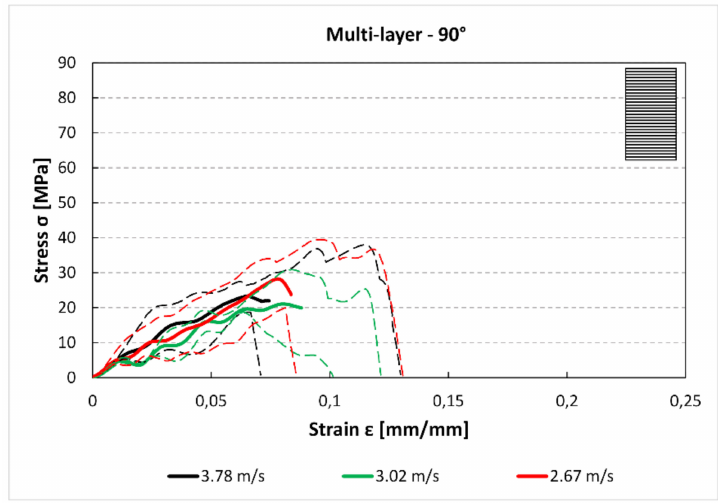
Figure 14. Multilayer stress–strain curves for 90 ◦ specimens and for each impact